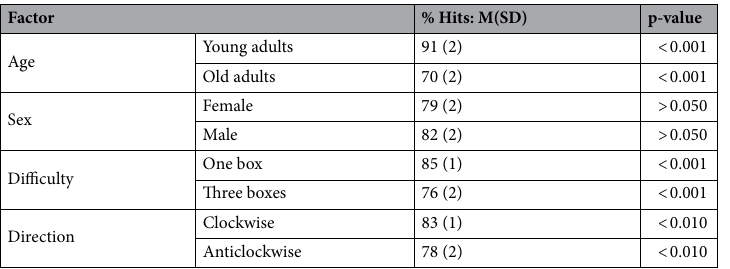
Table 1. Mean percentage of Hits for each factor, Age (old and young), Sex (female, male), Difficulty (one box and three boxes) and Direction (clockwise and anticlockwise). SD in brackets. (Triple asterisk means p-value < 0.001; double asterisk means p-value < 0.01; ns means p-value >